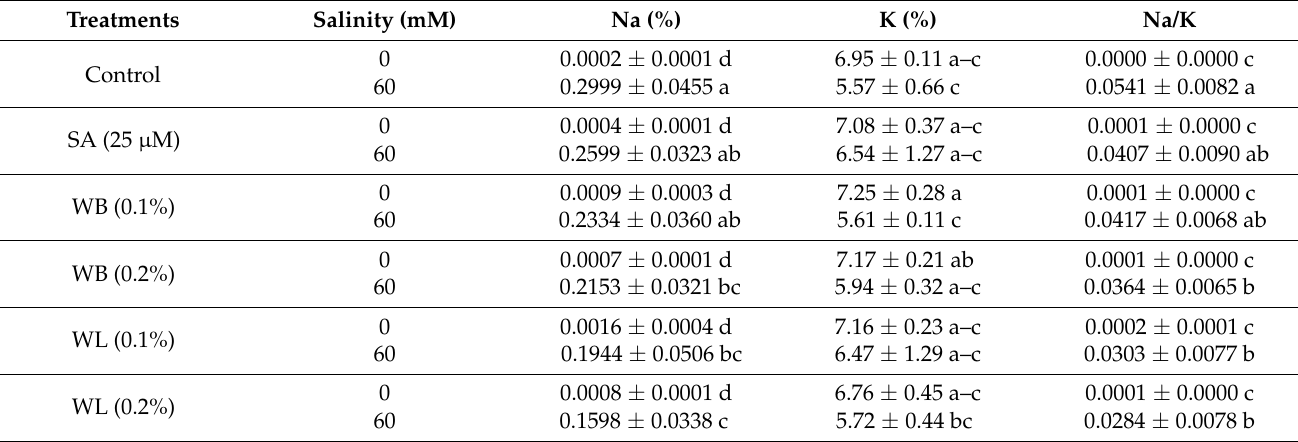
Table 4. Changes in shoot Na, K concentrations and Na/K ratio of 30 day-old hydroponically grown maize ( Zea mays cv. Caramelo) plants in response to salinity (non-salinity stress, 0 mM; salinity stress, 60 mM) and biostimulant applications (SA, salicylic acid (25 µ M); WB, willow bark extract (0.1% or